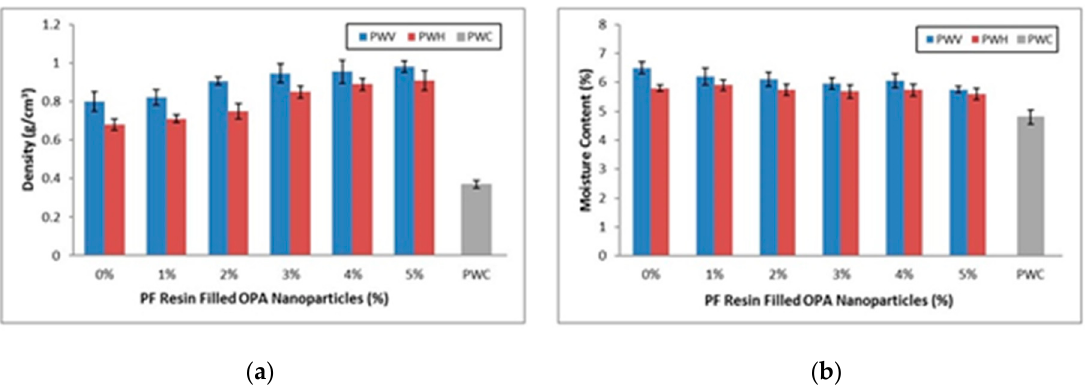
Figure 3. ( a ) Density profile and ( b ) moisture content of plywood veneer (PWV), hybrid plywood (PWH), and commercial plywood (PWC) with di ff erent loading of phenol-formaldehyde (PF) filled OPA